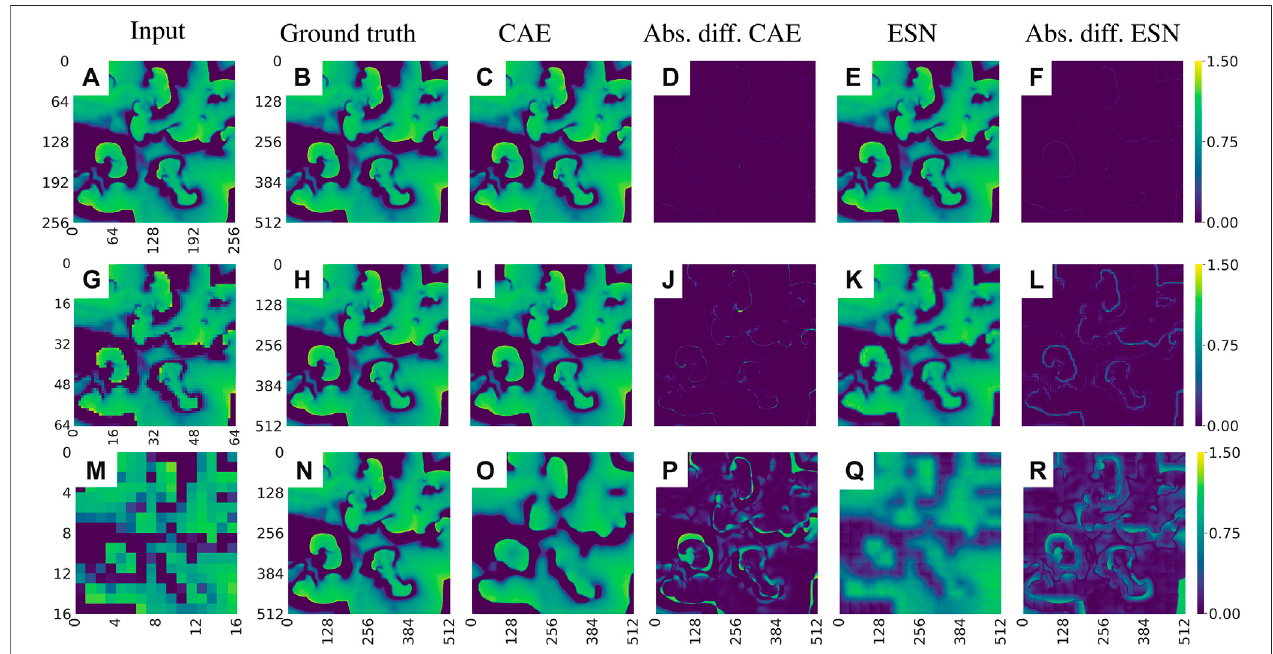
FIGURE12| Exemplaryvisualizationofthereconstructionofthe u - fi eldoftheBOCFmodelfromundersampleddata. (A) – (F) correspondstoasamplingparameter i (cid:2) 1resultingin X ∈ R 256 × 256 , (G) – (L) tocase i (cid:2) 3, X ∈ R 64 × 64 and (M) – (R) to i (cid:2) 5, X ∈ R 16 × 16 .With downsampling byafactor of2 1 reconstructions byboth networks, CAEs and ESNs, are both very successful and the absolute differences shown in (D) and (F) are nearly zero. Similar to reconstructions from noisy or blurred data errors occur mainly at the fronts of the waves, and reconstruction errors of the CAE appear to be more localized compared to ESN